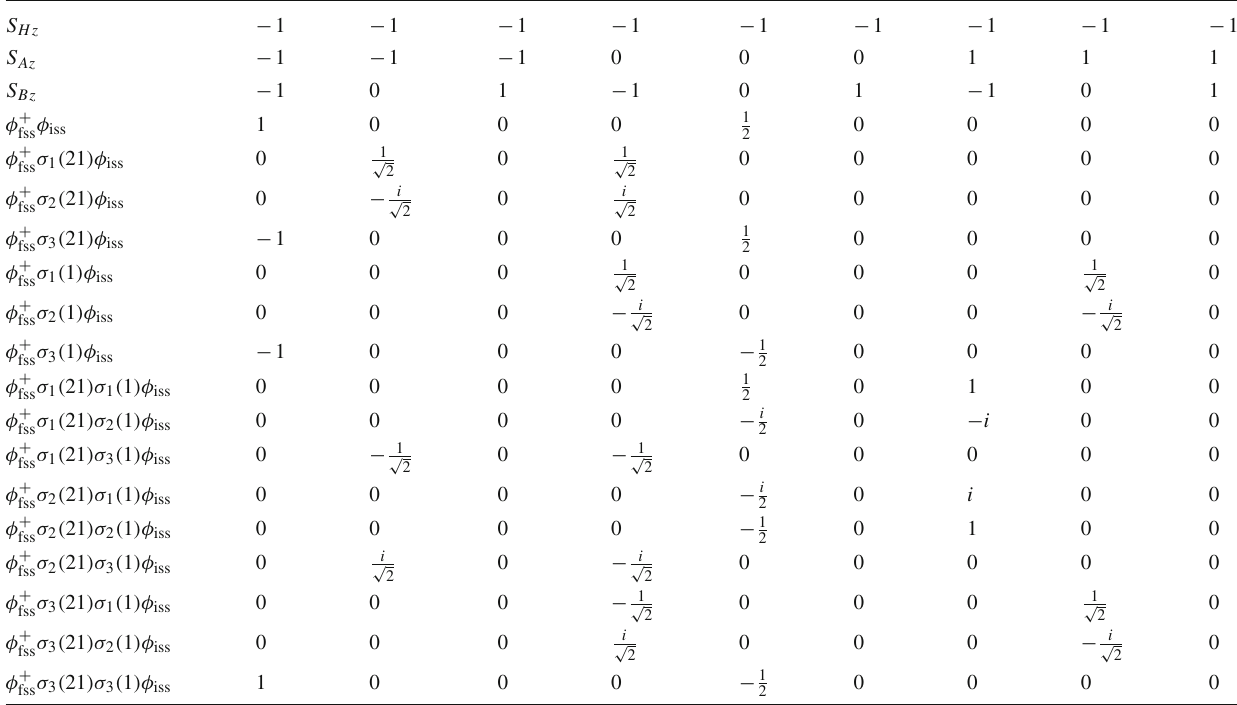
for A ( S A = 1 ) + B ( S B = 1 ) → H ( S H = 1 ) with S Hz = − 1 1 ¯ q 2 ¯ q 1